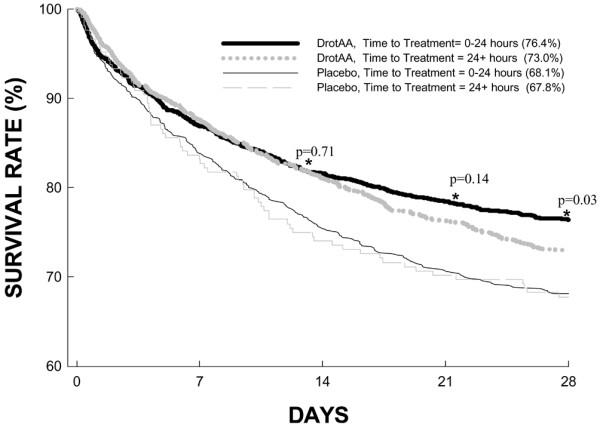
INDEPTH survival curves for placebo-receiving and DrotAA-treated patients by time to treatment. The percentage 28-day survivals are shown parenthetically in the key. Kaplan-Meier survival curves are displayed for therapy groups (namely DrotAA and placebo), as well as for time-to-treatment groups (namely 0 to 24 hours and more than 24 hours). Both DrotAA time-to-treatment curves were significantly different from the placebo time-to-treatment curves. At 14 days, the DrotAA earlier treatment curve (0 to 24 hours) started to diverge from the later treatment curve (more than 24 hours). The difference between the DrotAA earlier and later treatment curves was significant at 28 days (p = 0.03). DrotAA, drotrecogin alfa (activated).